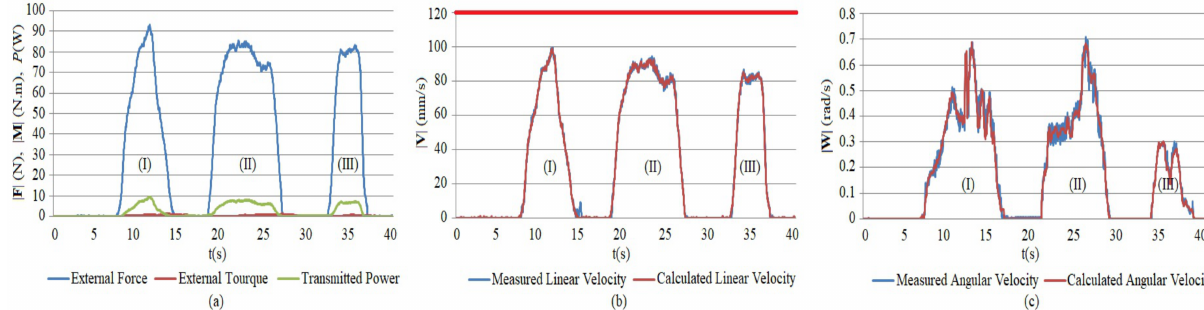
Figure 10. Experimental results using MLP-HA-based admittance controller, ( a ) presents the inputs | F | (N), | M | (Nm) and P (W); ( b ) and ( c ) present outputs | V | (mm/s) and | W | (rad/s), respectively.